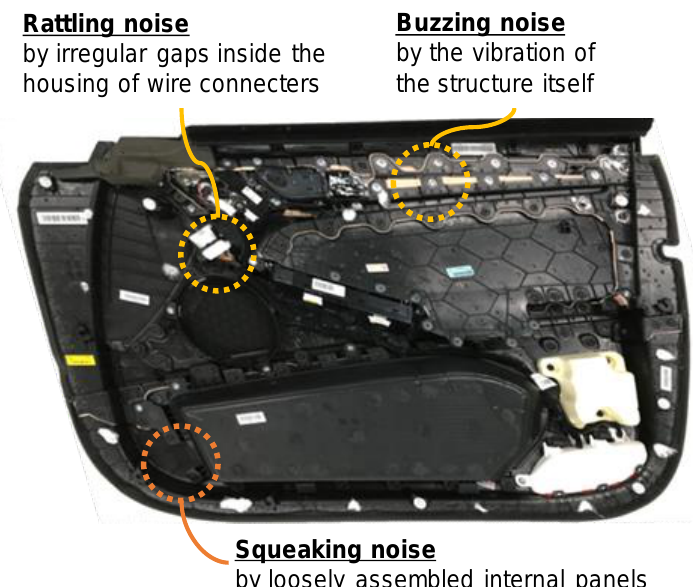
Figure 1. Possible sources of noise in a car door trim panel: buzzing, squeaking, and rattling noise.